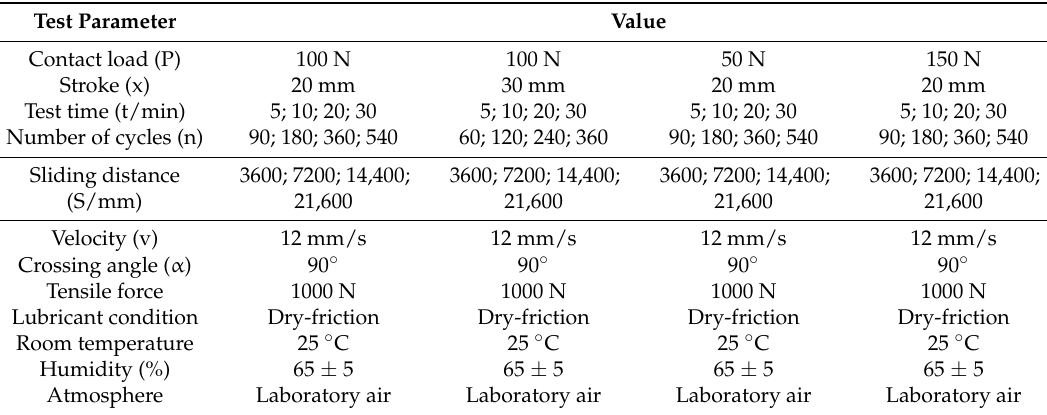
Table 2. Friction and wear experimental